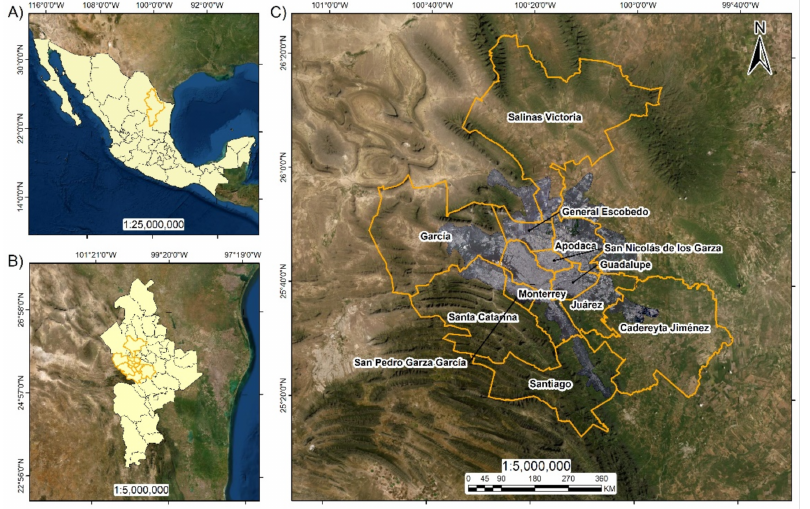
Figure 1. Study area location. ( A ) State of Nuevo Leon within the Mexican Republic; ( B ) Monterrey Metropolitan Area (MMA) within the state of Nuevo Leon; ( C ) orthomosaic of WorldView-2 coverage of the